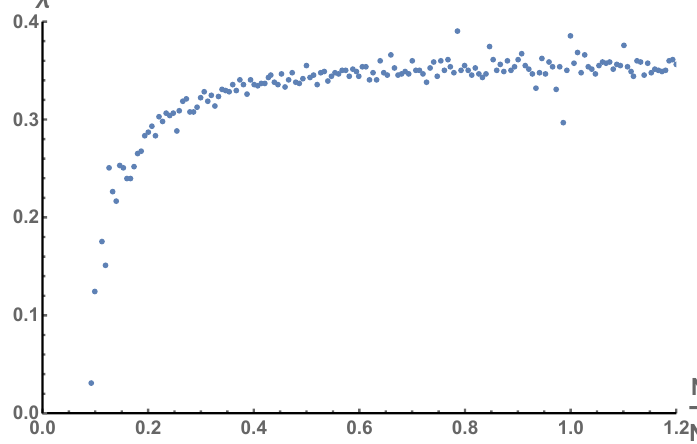
Figure 4 . The leading Lyapunov exponent in terms of number of (cid:13)avors over number of colors. The main result is that in the region N f (cid:24) N c the exponent quantifying the chaotic motion is weakly depending on the number of (cid:13)avors. It is tempting to extend our computation for lower values of (cid:13)avor pushing the limits of the validity of our background. Starting from small values of N f =N c and increasing, we see that the exponent quickly converges to the constant value already at N f (cid:24) 0 : 4 N c .